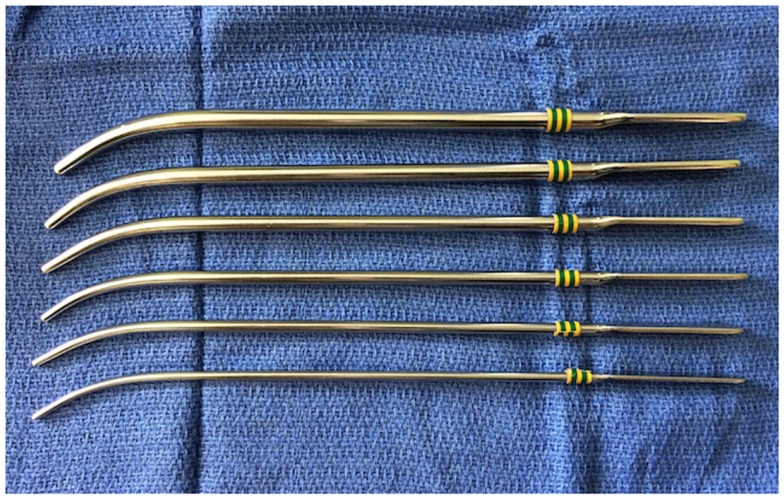
Urethral sounds in various sizes.